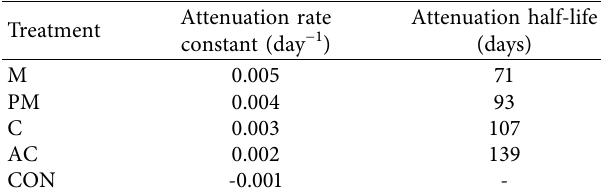
Table 3: Attenuation rate constant and attenuation half-life of TPH as calculated using the first-order model.